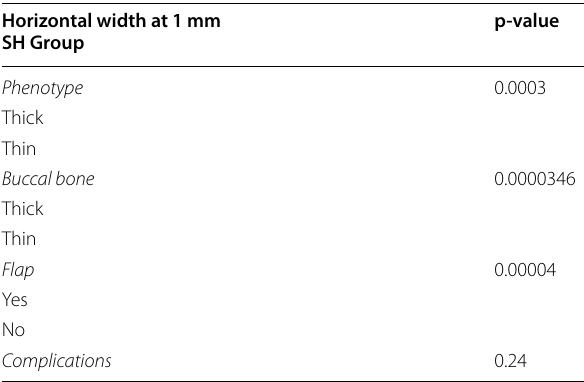
Table 2 Summary of the variables considered for the t test